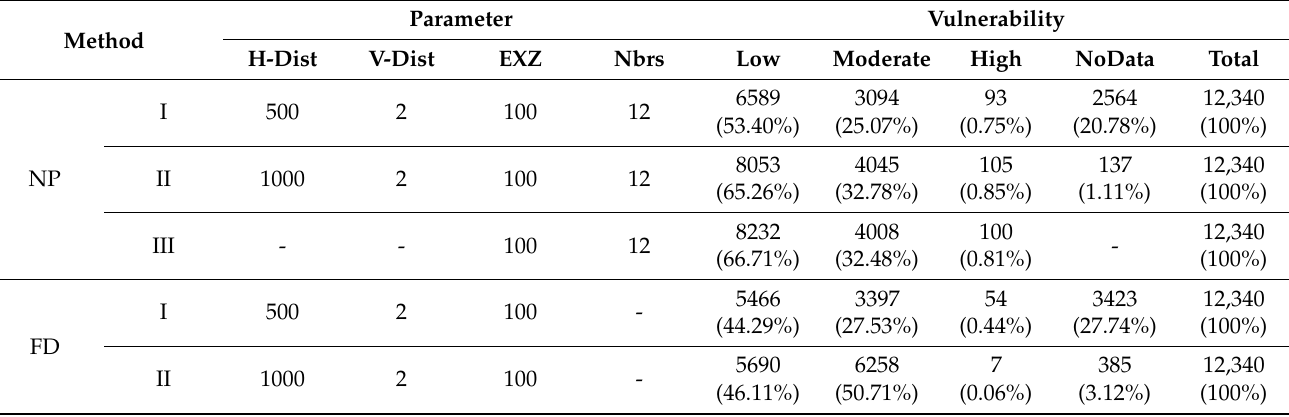
Table 1. Summary of 1st interpolation results.